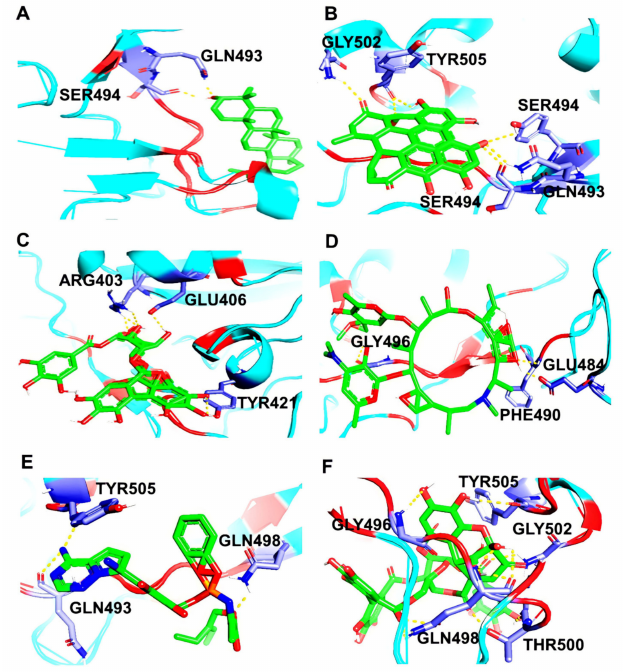
Figure 8. 3D diagram of SARS-CoV-2 Delta S RBD in complex with ( A ) Lupeol, ( B ) Hypericin, ( C ) Corilagin, ( D ) Geraniin, ( E ) Remdesivir, and ( F ) Azithromycin. The interacting amino acid residues and the ligand molecules in the protein-ligand complexes are illustrated as blue and green sticks, respectively. The yellow dotted lines represent the hydrogen bonds formed between the protein and the ligand. Table 2. Molecular docking results of potential compounds against Delta S